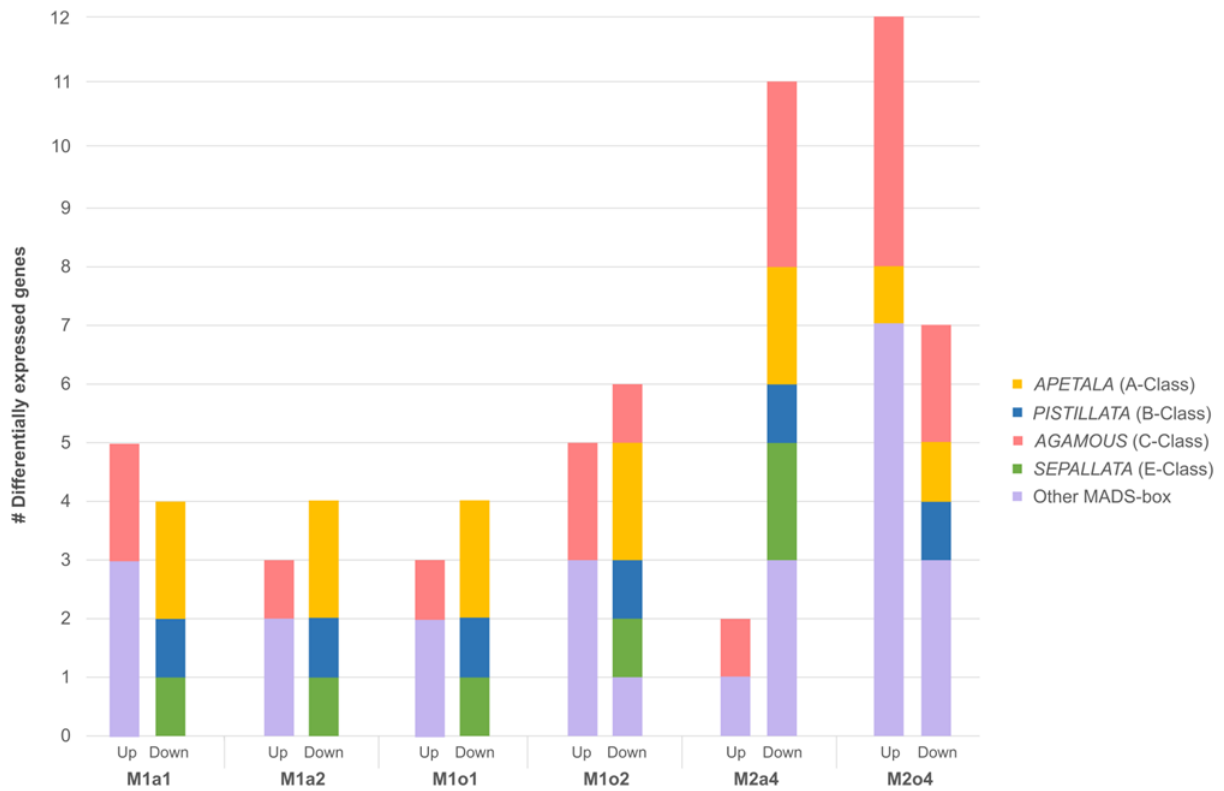
Figure 2. Distribution of differentially expressed genes related to floral development in ovules from apomictic L. multiflorum (M), sexual L. auriculifolium (a) and L. ovalifolium (o), and facultative apomictic L. dodartii (d). Differentially expressed MADS-box genes APETALA (A-class), PISTILLATA (B-class), AGAMOUS (C-class), SEPALLATA (E-class), and other MADS-box genes are represented. DEGs were found in apomictic ovules in S1 relative to sexual ovules in S1 (M1a1 and M1o1) and S2 (M1a2 and M1o2), and relative to sexual ovules in S3/S4 (M2a4 and M2o4), and facultative apomictic in S4 (M2d4). Table 4. List of florally differentially expressed genes (DEGs) in ovules of Limonium plants, namely apomictic L. multiflorum (M), sexual L. auriculifolium (a), and L. ovalifolium (o). DEGs were found in apomictic ovules in S1 relative to sexual ovules in S1 (M1a1 and M1o1) and S2 (M1a2 and M1o2), and in apomictic ovules in S2 relative to sexual ovules in S3/S4 (M2a4 and M2o4); (red: up-regulated DEGs; blue: down-regulated DEGs).